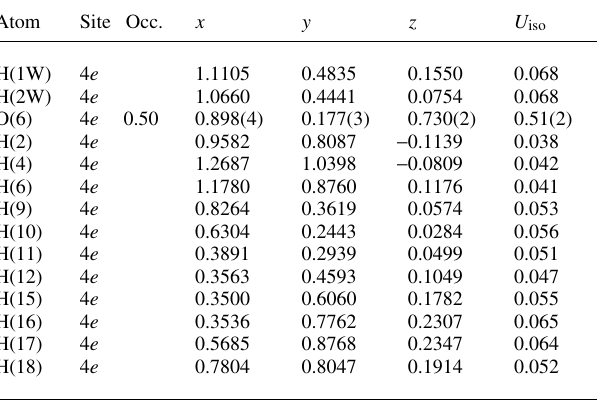
Table 2. Atomic coordinates and displacement parameters (in Å 2 )